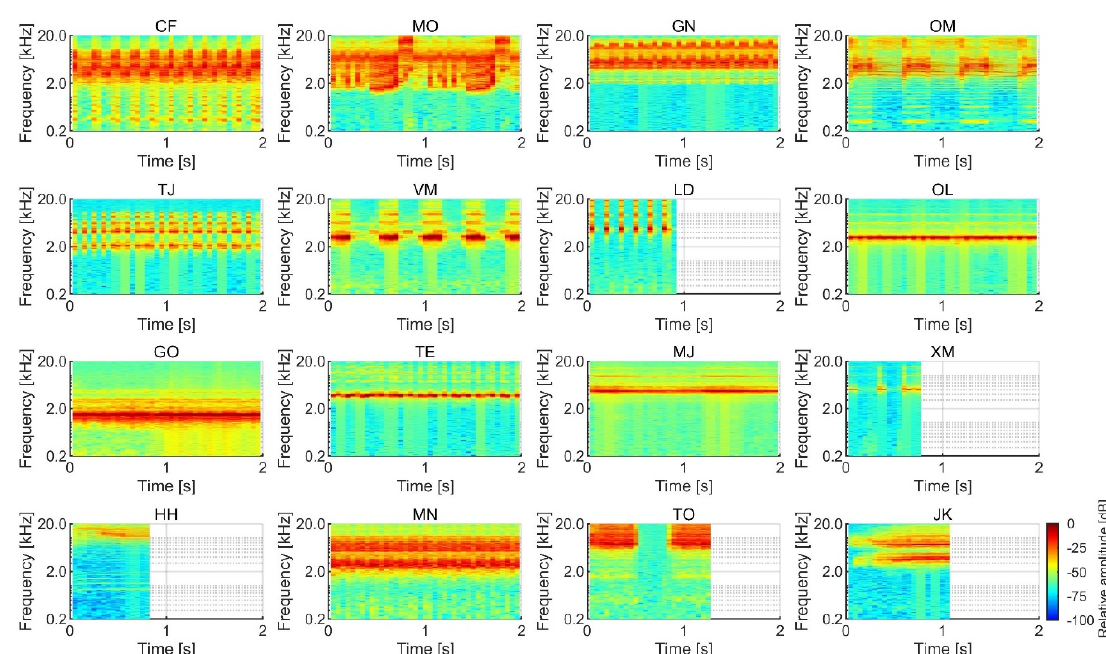
Figure 4. Spectrograms of the 16 insect songs.